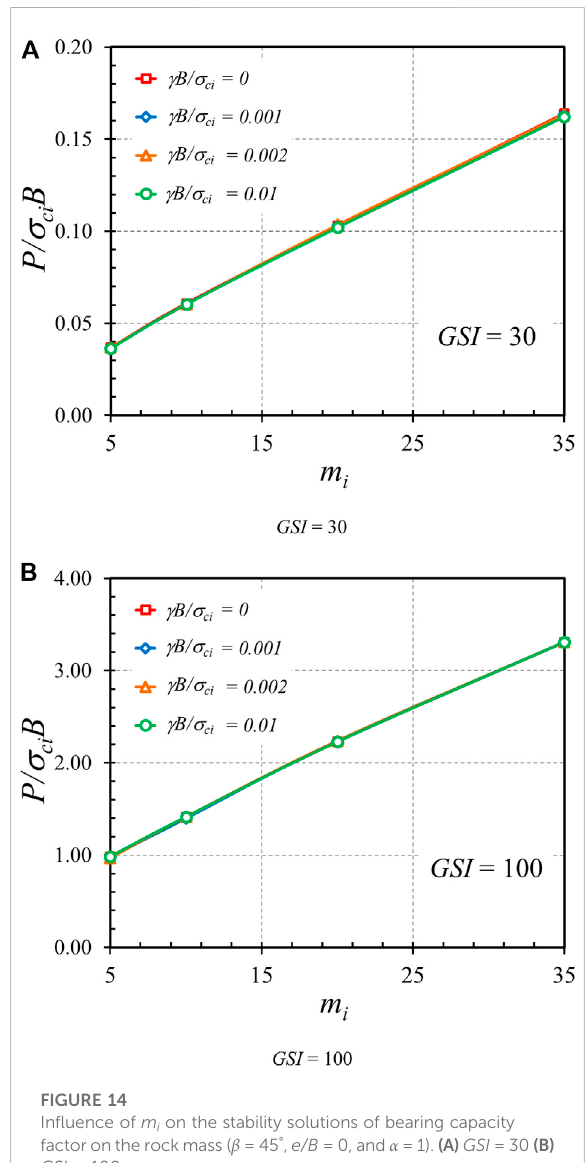
FIGURE 14 In fl uence of m i on the stability solutions of bearing capacity factorontherockmass( β =45 ° , e/B =0,and α =1). (A) GSI =30 (B) GSI =